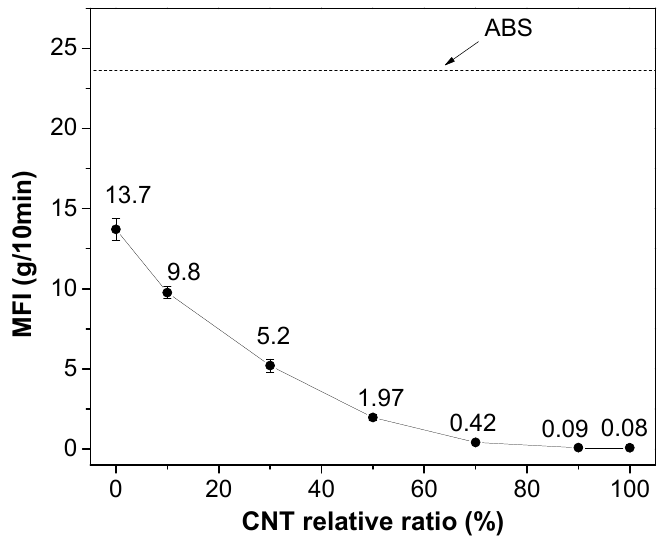
Figure 2. Melt flow index (MFI) (220 °C/10 kg) of 6 wt.% GNP/CNT nanocomposites with different CNT contents.